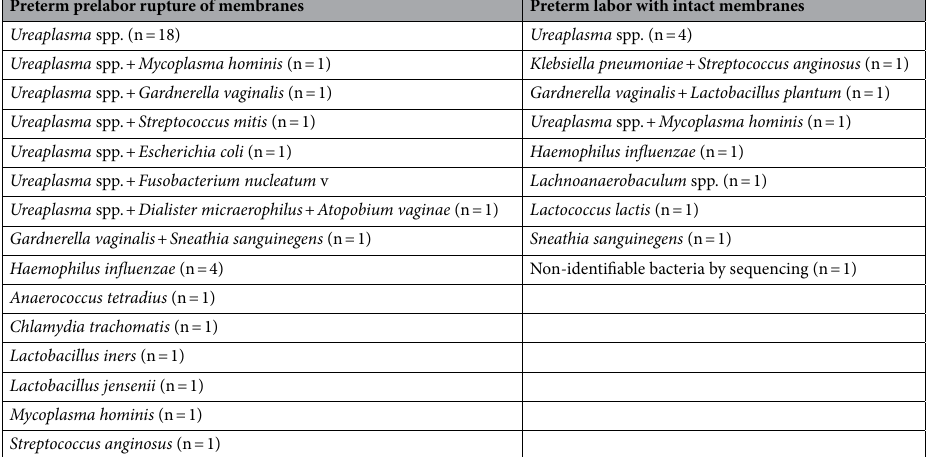
Preterm prelabor rupture of membranes Preterm labor with intact